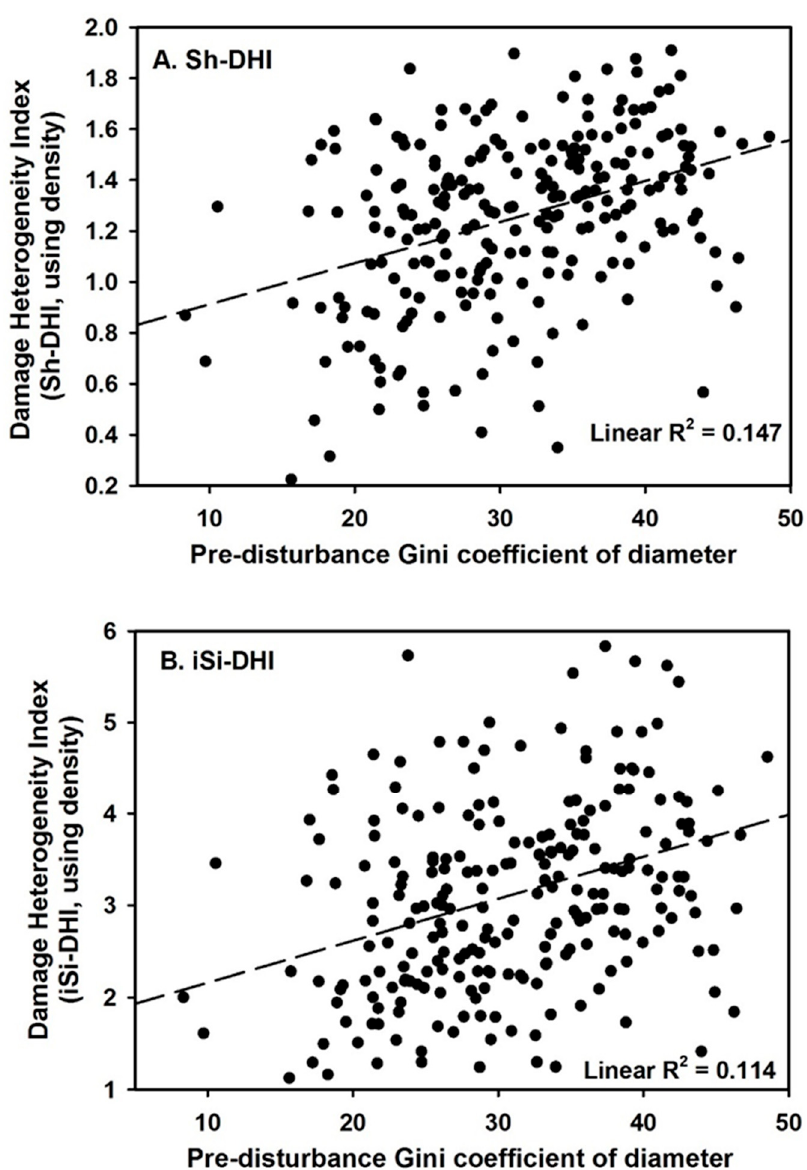
Figure 6. Damage heterogeneity index vs. pre-disturbance tree size inequality, for plots with 5-cm diameter minimum; n = 111. ( A ) DHI calculated with the Shannon formula; ( B ) DHI calculated with the inverse Simpson formula. Only significant ( p < 0.05) regression results shown.